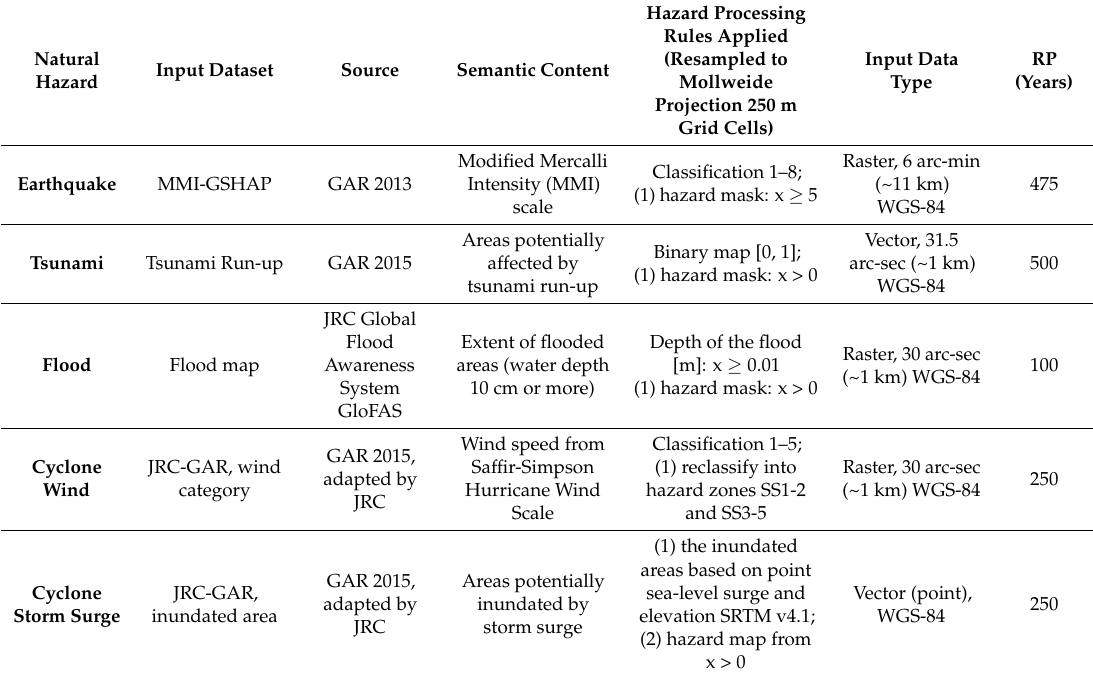
Table 1. Comprehensive overview of the hazard layers used in this